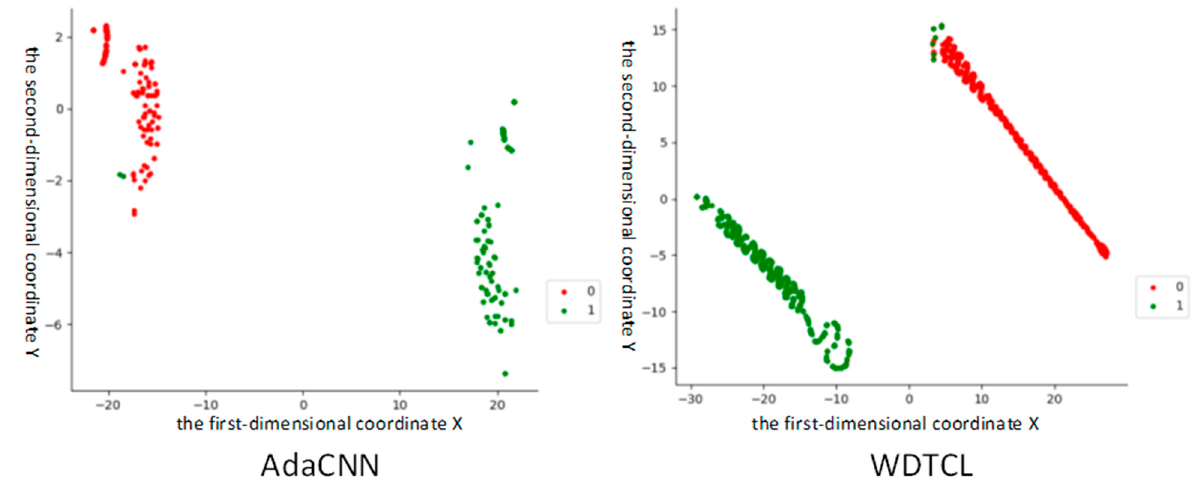
Figure 6. Comparison of visualization effects of the second convolutional layer when fault diagnosis knowledge is transferred between different working conditions.